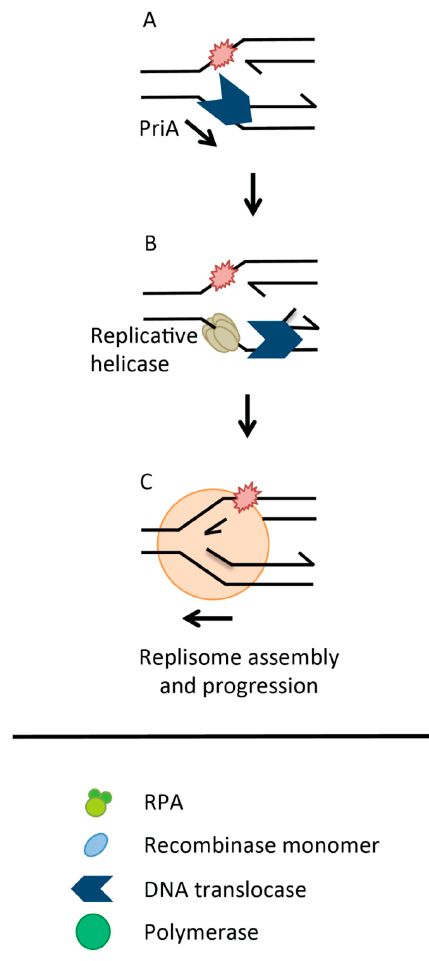
Figure 2. Direct Replication Restart. ( A ) PriA * recognizes branched DNA structures arising at stalled replication forks. It remodels forks to present substrates for binding by replicative helicase loading proteins PriB and PriC; ( B ) Recruitment of the replicative helicase DnaB for loading onto the lagging strand template allows replication to be re ‐ activated; ( C ). * Protein nomenclature here refers to E. coli . 3. Recombination Initiated from ssDNA: Nucleoprotein Filaments and D ‐ loops Strand exchange reactions (synapsis) are universally catalysed by recombinase enzymes of the RecA family that are commonly called RecA in bacteria, Rad51 in eukaryotes, and RadA in archaea [24]. Most sequence similarity between recombinases resides within essential Walker A and B motifs that confer ATPase activity. Recombinase catalysed synapsis reactions are relatively well studied by biophysical, structural, biochemical and genetic analyses. To be able to understand molecular mechanisms of how synapsis is regulated it is important to unravel details of recombinase structure ‐